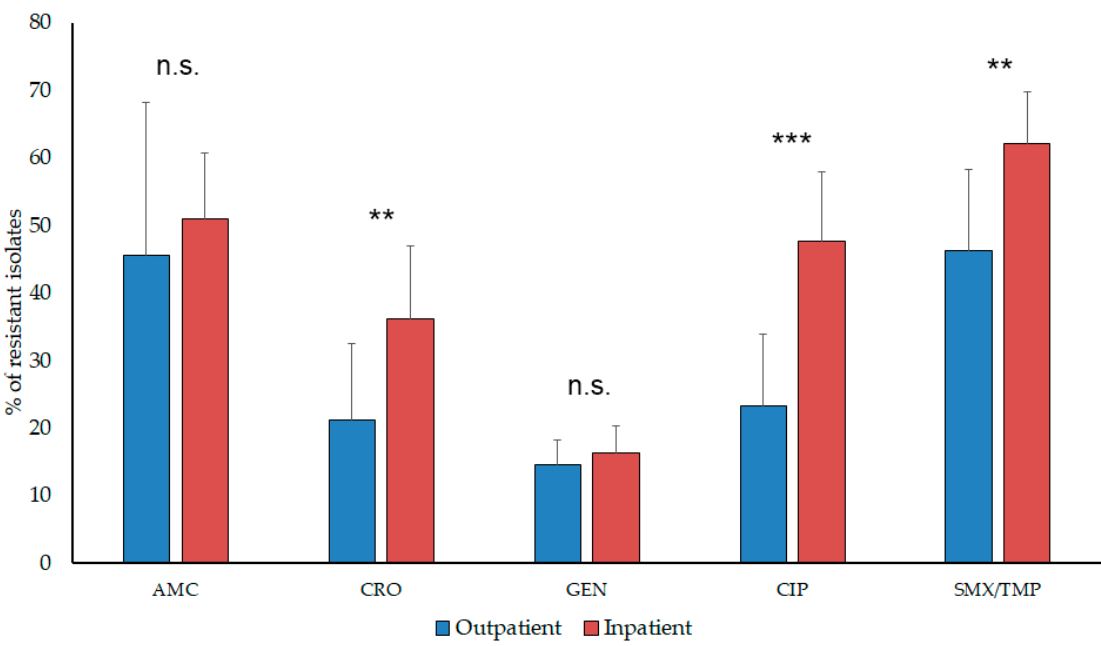
Figure 2. Resistance levels of Proteae originating from inpatient and outpatient urinary tract infections AMC resistance levels correspond to P. mirabilis isolates